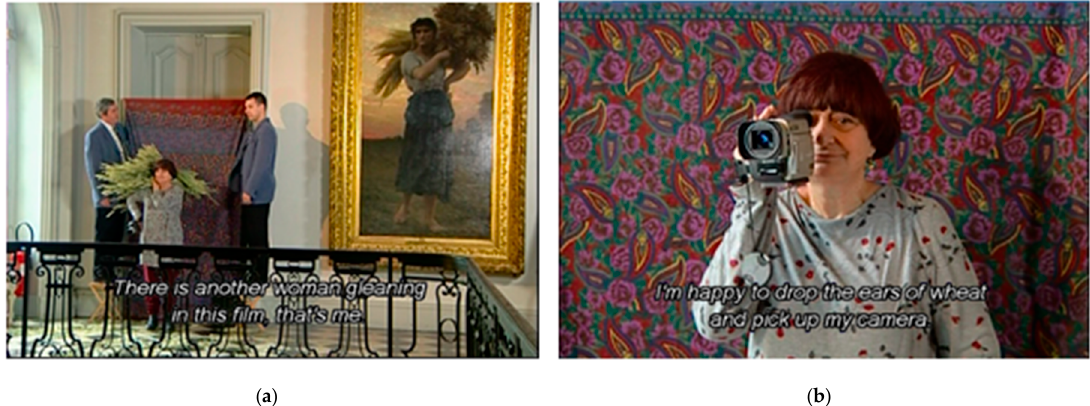
Figure 1. ( a ): Varda posing in the style of Jules Breton’s La Glaneuse , displayed in the background; ( b ): Varda gleans with her